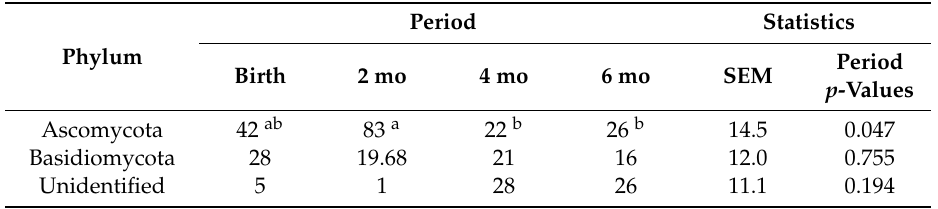
Table 3. Infant oral fungi categorized over time (% of sequences).